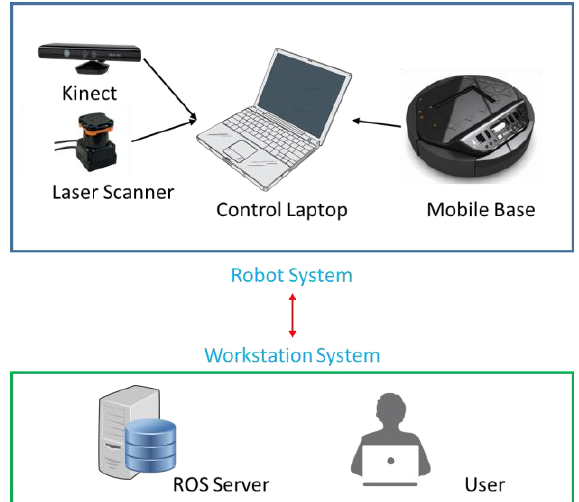
Figure 1. The indoor robot system and Architecture